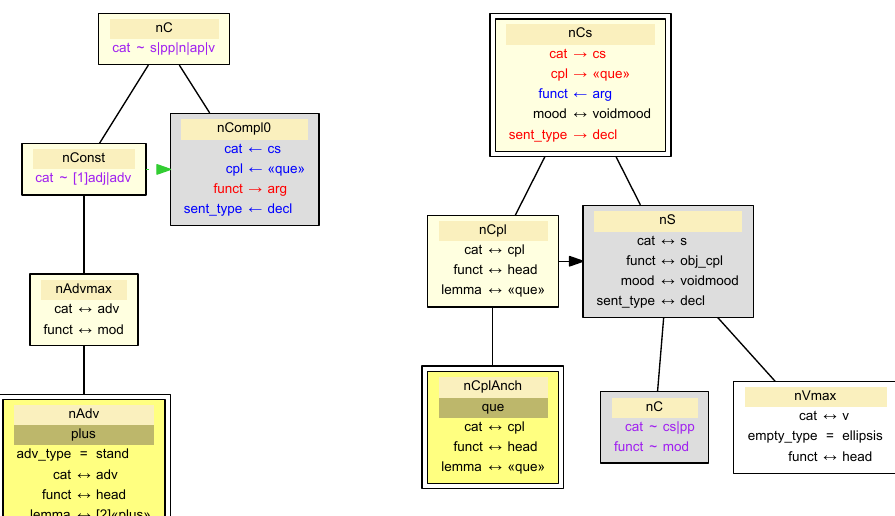
Figure 18: EPTDs anchored by plus and que for the parsing of Sentence (22) It reduces to the prepositional phrase en hiver and the complete clause would be il ne l’est en hiver . The elided verb is represented by the node nVmax and the node nC represents the complement en hiver